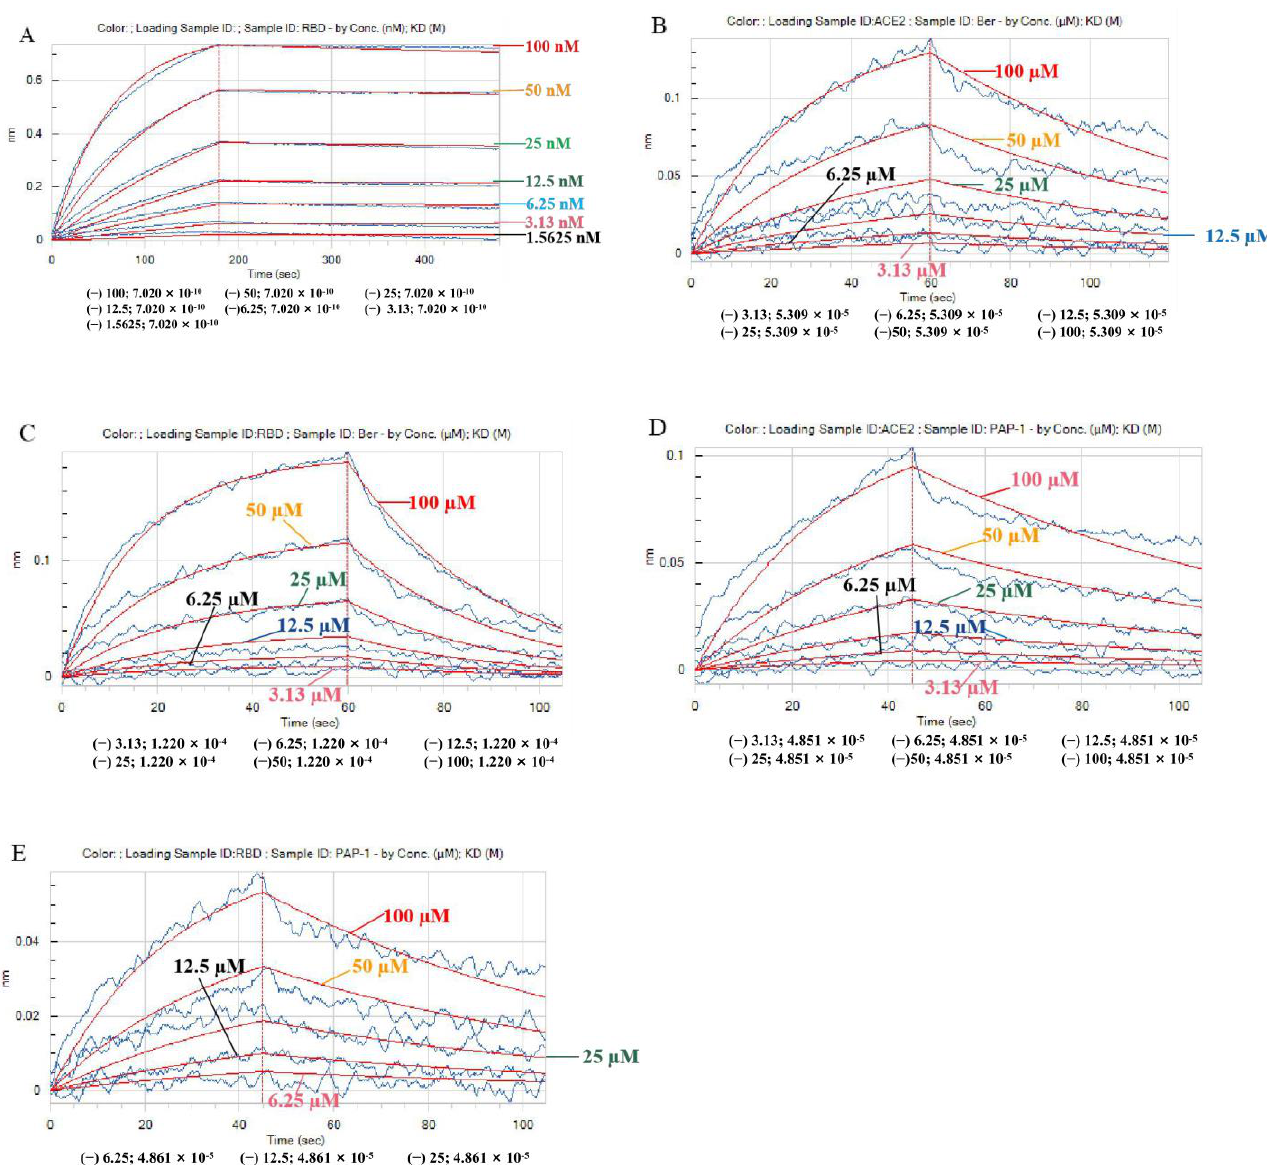
Figure 2. ( A ) The interaction between the RBD Spike S protein and recombinant ACE2 protein was analyzed by BLI assay; binding affinity using an Octet RED96e system. Seven different RBD Spike protein concentrations including 1.56, 3.13, 6.25, 12.5, 25, 50, and 100 nM were set. Response (y axis) was measured as a shift in nm in the interference pattern and was proportional to the number of molecules bound to the surface of the biosensor. Response was recorded and displayed on a sensor- gram in real time. The data points are represented by blue lines and the fitted data are shown as red lines. ( B ) Interaction between bergamottin and recombinant ACE2 protein was analyzed by BLI as- say. Six different bergamottin concentrations including 3.13, 6.25, 12.5, 25, 50, and 100 µM were set. ( C ) Binding affinity measurements of bergamottin and RBD Spike S protein using BLI. Representa- tive sensorgrams obtained from the injection of different concentrations of bergamottin (3.13, 6.25, 12.5, 25, 50 and 100 μM). ( D ) Interaction between PAP-1 (3.13, 6.25, 12.5, 25, 50 and 100 µM) and recombinant ACE2 protein was analyzed by BLI assay. ( E ) Interaction between PAP-1 (6.25, 12.5, 25, 50 and 100 µM) and recombinant RBD Spike protein was analyzed by BLI assay.